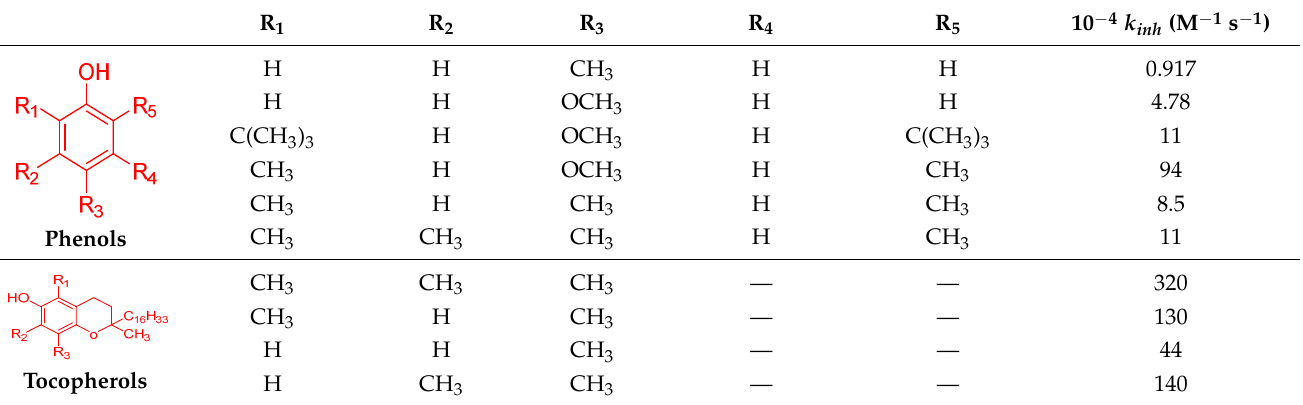
Figure 5. Radical scavenging activity of catechol derivatives, where R stands for different substituents. Table 2. Inhibition rate constants ( k inh ) for the reaction between different ArOH and polystyrene peroxyl radicals. Data from ref. [33]. Adapted from reference [10].